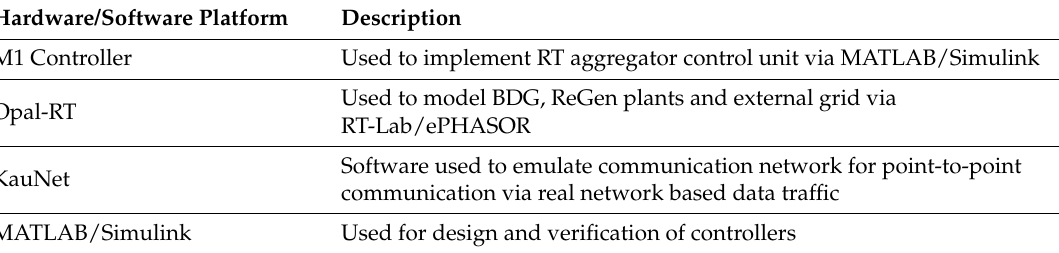
Table 1. Summary of involved suites and their role